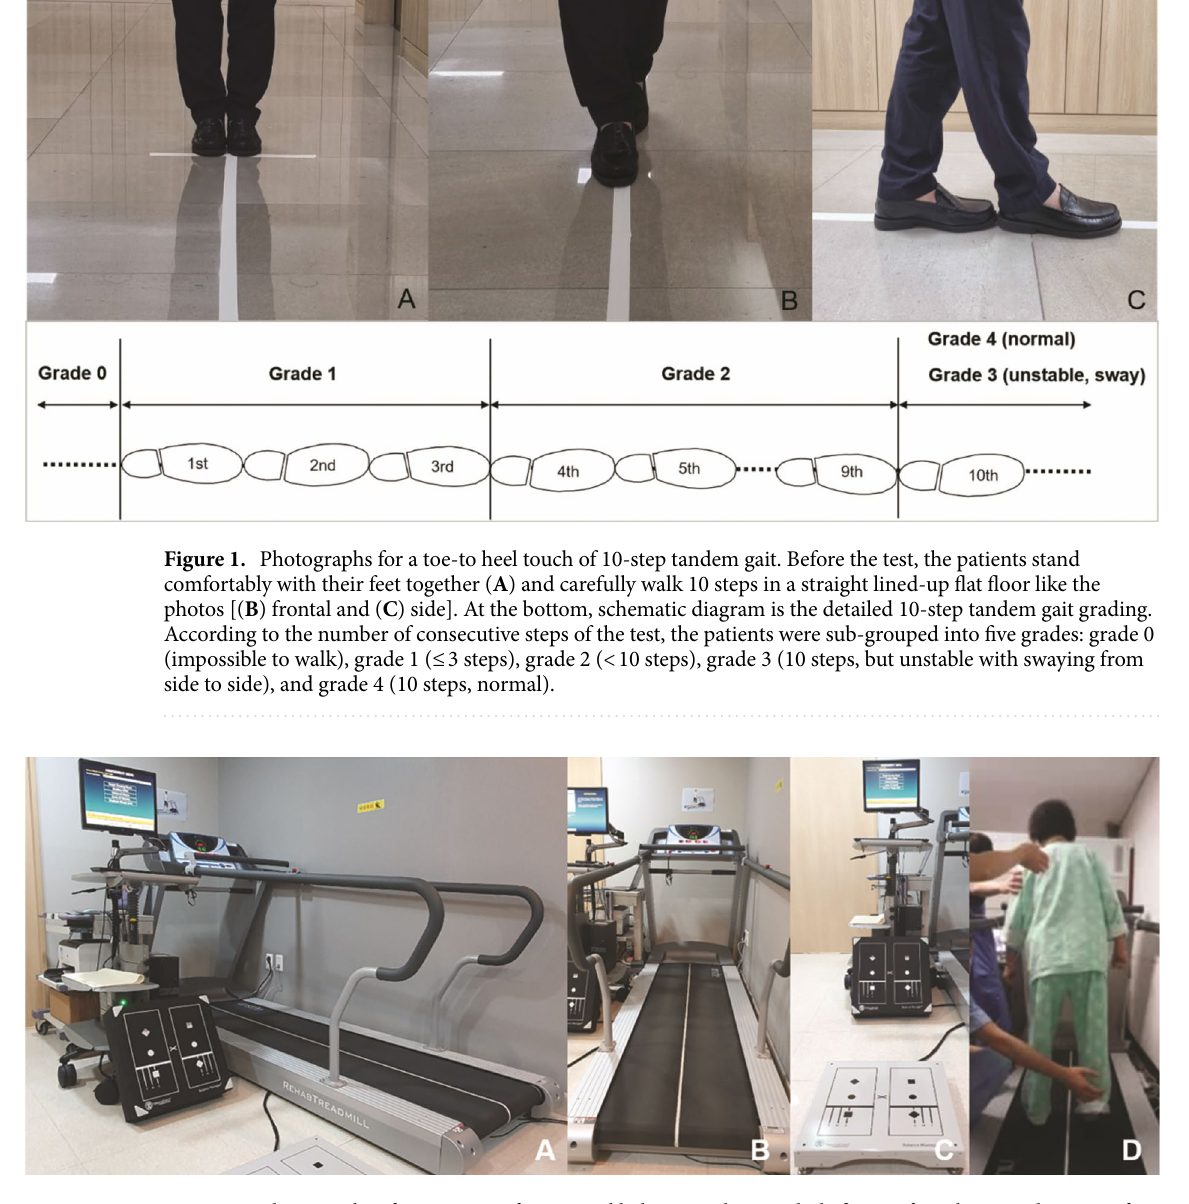
Figure 2. Photographs of instruments for gait and balance analyses. Whole figure of machines and setting of gait analysis room were shown ( A ). Each instrument for gait ( B ) and balance ( C ) analysis lied at the side and in case of unstable gait of the patient, the test was performed with special care to keep the patient from slipping down ( D to shift their weight following the cursor displayed on the screen. The outcome variables were the mean COG movement speed (deg/s) and directional control (%). Composite scores for COG velocity and directional control were generated by averaging all trials performed in two directions.